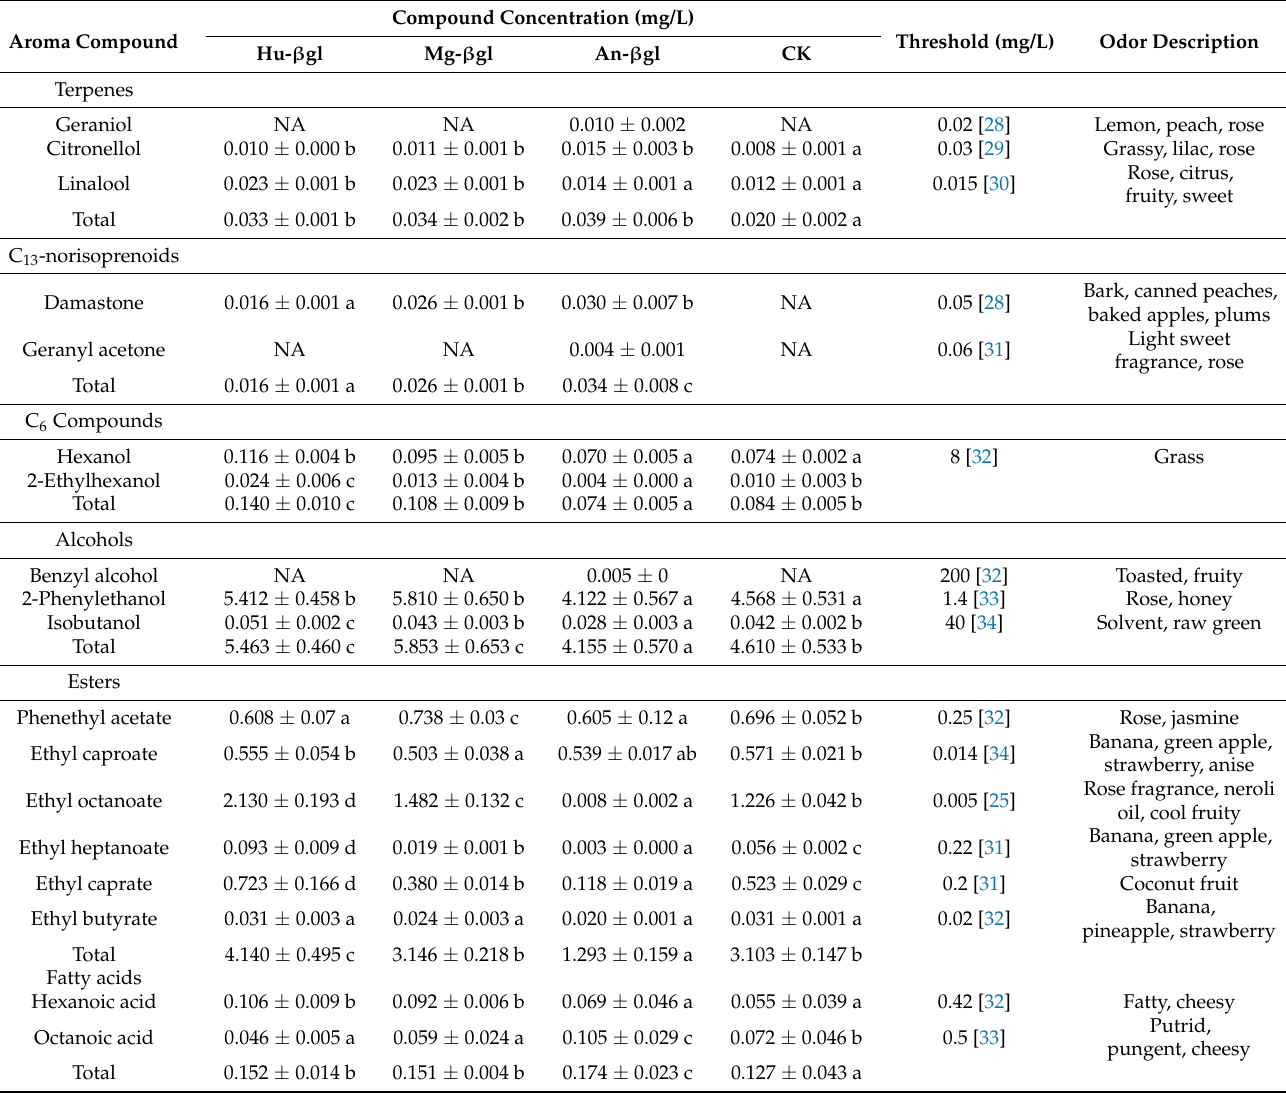
Table 2. Volatile aroma compounds of Chardonnay wines treated with purified enzymes (Mg- β gl and Hu- β gl) and An- β